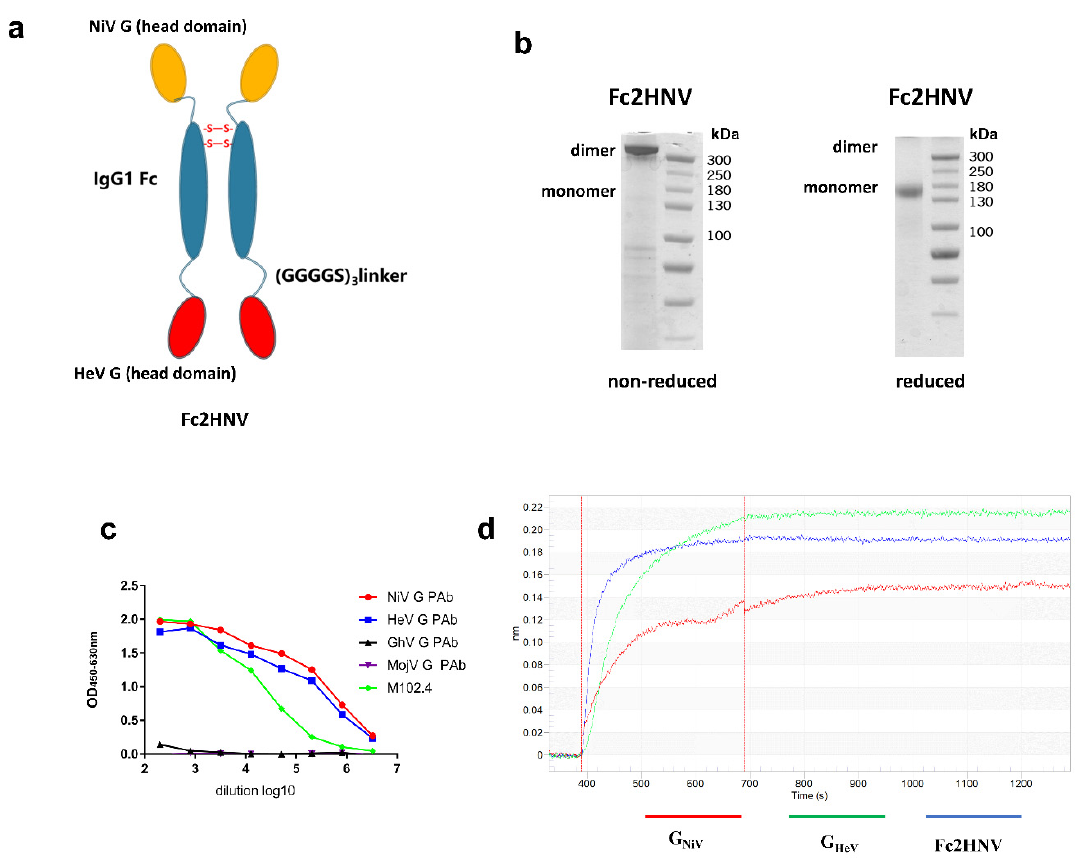
Figure 5. Construction and characterization of bivalent fc-fusion proteins. ( a ) Schematic diagram of the Fc-fusion protein Fc2HNV. The Fc2HNV contains the head domains of G NiV and G HeV . The head domain of G NiV , the human IgG1-Fc domain, and the head domain of G HeV were connected in sequence. These three domains were separated by two (Gly4Ser)3 flexible linkers. To obtain the secreted Fc-fusion protein, a tPA signal peptide was added at the N-terminus of the protein. ( b ) Fc2HNV assessed on a non-reduced and reduced SDS-PAGE gel. ( c ) Binding curves of Fc2HNV with M102.4 or pAbs against the G proteins of HNVs. The curves were determined by ELISA with the M102.4 diluted from 20 µ g / mL. ( d ) Binding curves of Fc2HNV, G NiV , and G HeV with the ephrinB2 receptor. The curves were determined by a biolayer interferometry assay. Data of the association and dissociation steps are presented, and all curves were aligned by a baseline step.